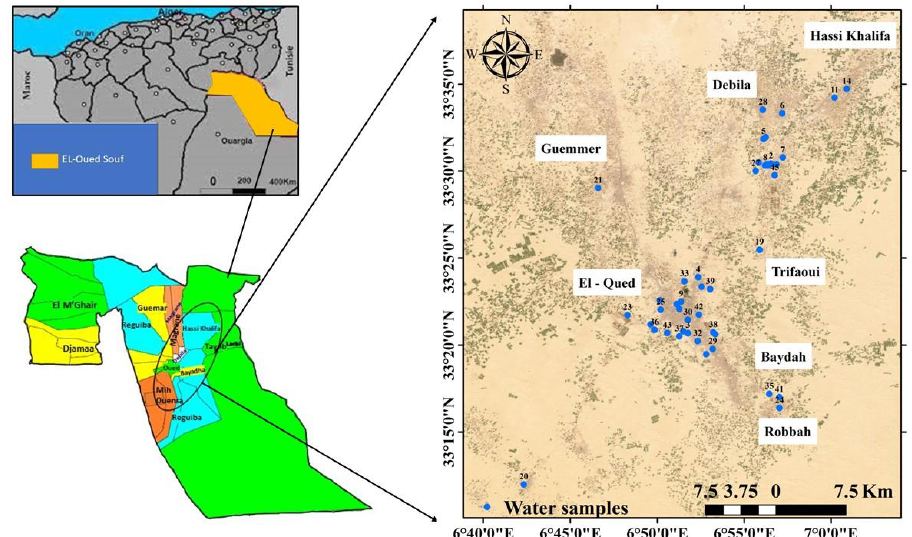
Figure 1. Groundwater samples and location map of Souf Valley.